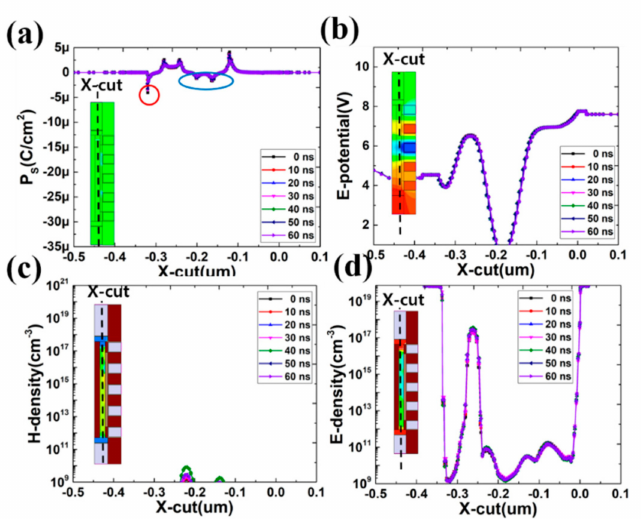
Figure 9. Various electrical changes that suppress the threshold voltage change in the program suppression operation: ( a ) change in the amount of minuscule, ( b ) potential in the channel, ( c ) hole density in the channel, ( d ) electron density in the